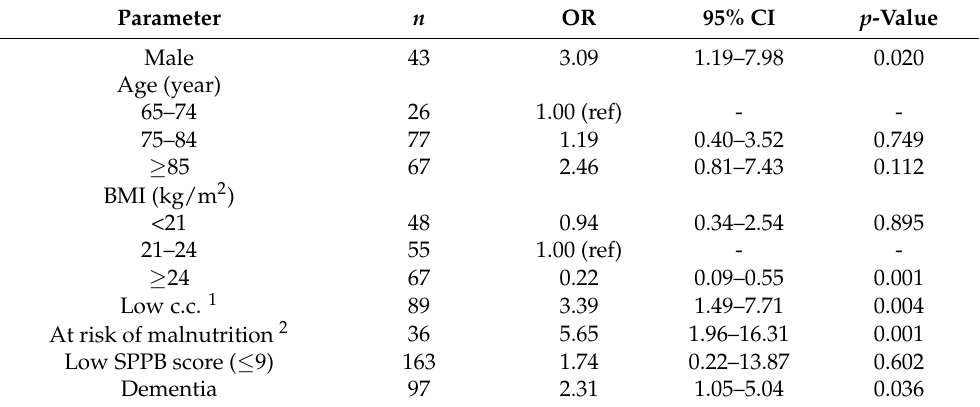
Table 3. Associated parameters of confirmed sarcopenia among older adults in daycare